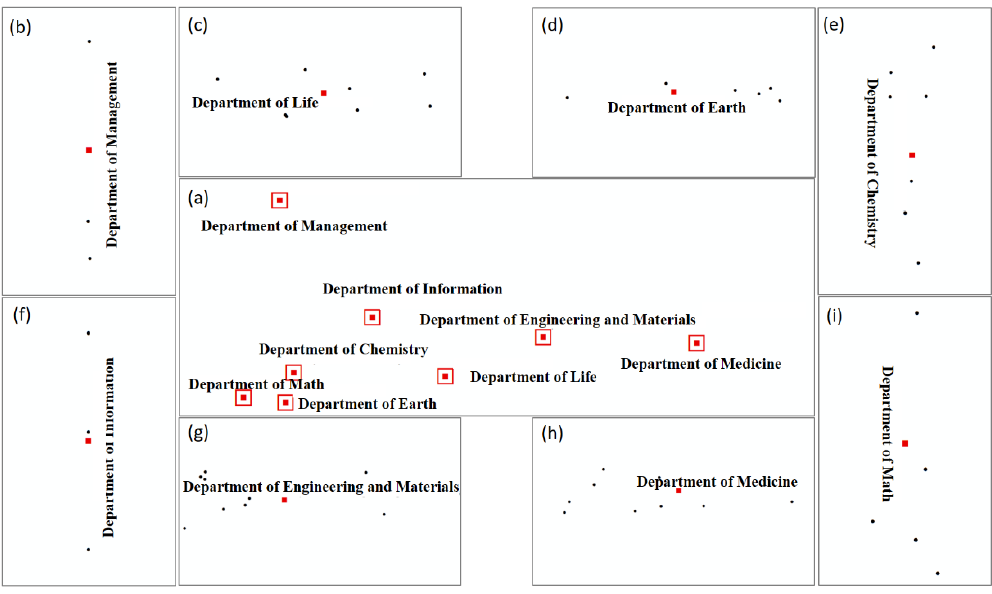
Figure 17. Hierarchical spatial layout of the experimental data.